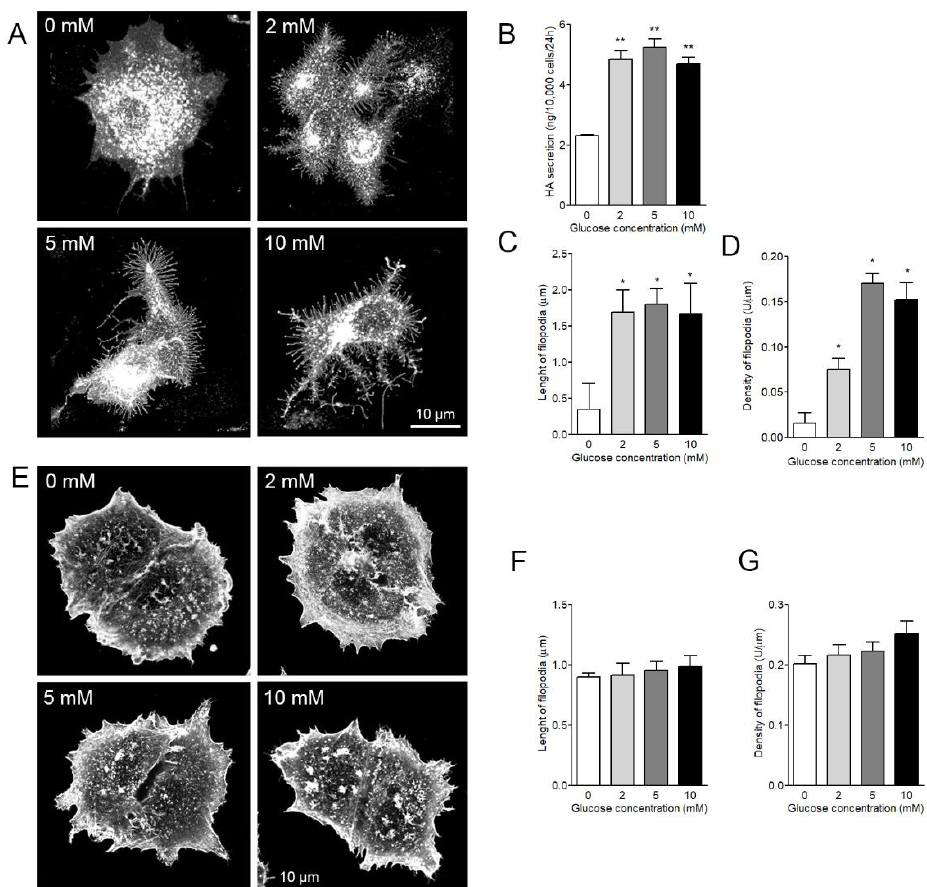
Figure 4. Both length and density of HAS3-induced filopodia are dependent on glucose levels. ( A ) Examples of live MCF-7 cells grown in different glucose concentrations. ( B ) The levels of hyaluronan secretion in different glucose concentrations and ( C ) FiloQuant analysis of the length and ( D ) density of filopodia in live cells. ( E ) Examples of fixed and phalloidin-stained MCF-7 cells grown in different glucose concentrations. FiloQuant analysis on the ( F ) length and ( G ) density of fixed and phalloidin-stained cells grown in the same concentrations of glucose. One-way ANOVA, * p < 0.05, ** p < 0.01, as compared to control. ( n = 5 independent experiments with 18–30 cells/group in each experiment).